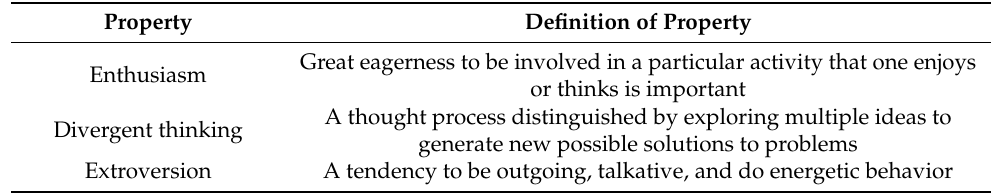
Table 7. Without underlying health conditions.